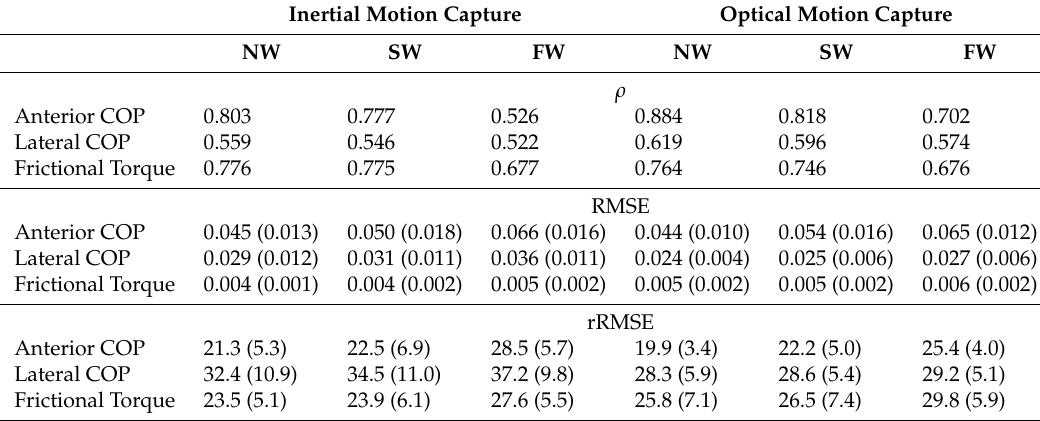
Table 7. Comparison of center of pressure (COP) and frictional torque estimated from inertial motion capture and optical motion capture versus force plate measurements. ρ = Pearson’s correlation coefficient, RMSE = root mean square error in m for COP and Nm/BW * BH for frictional torque, rRMSE = relative root mean square error (%). Analysis performed over stance phase for normal (NW), slow (SW) and fast walking (FW) trials for the decomposed right and left quantities. Inertial Motion Capture Optical Motion Capture